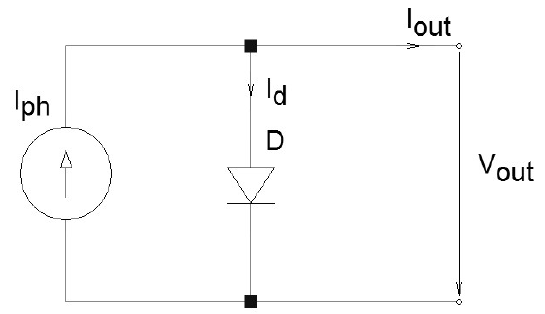
Figure 4. Equivalent circuit of ideal PV simulation model.